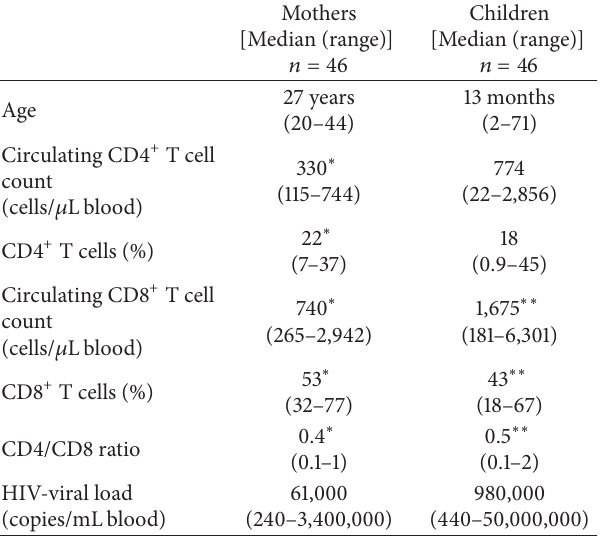
Table 1: Demographic data of paired mothers and their